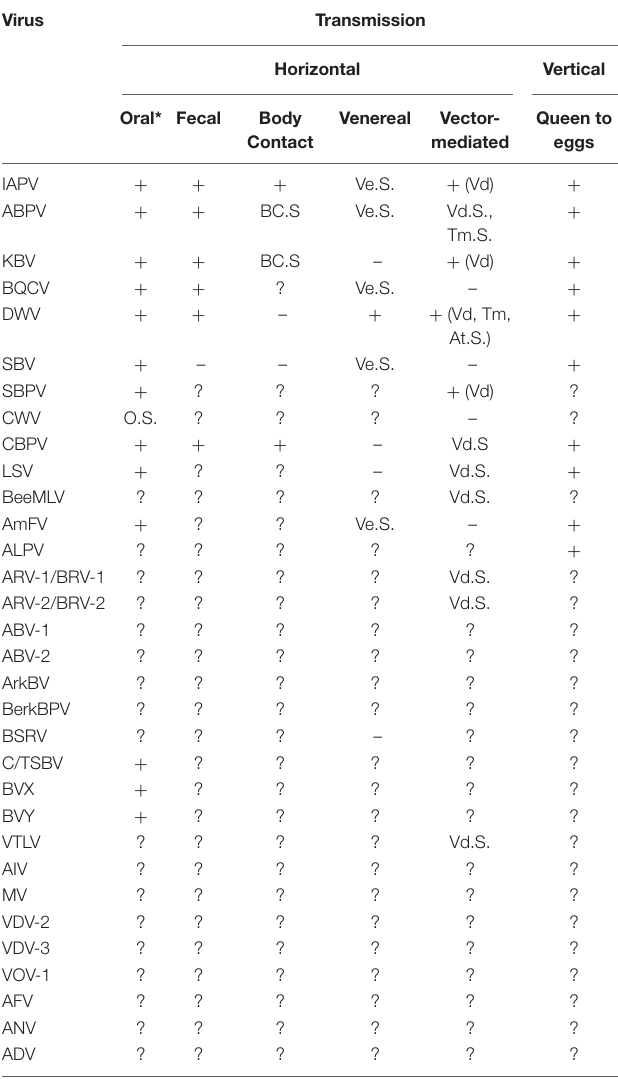
TABLE 1 | Routes of infection of viruses associated with honey bees. Overview of their horizontal and vertical transmission